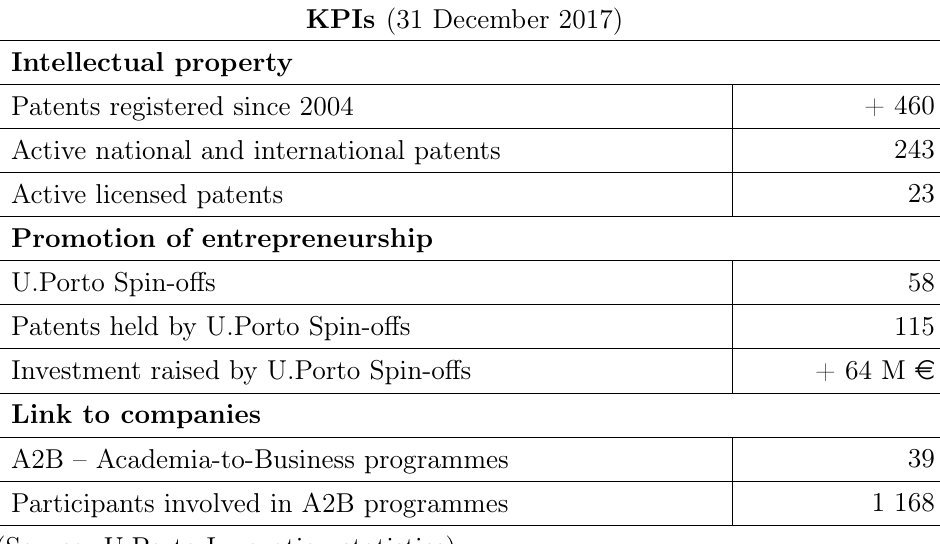
Table 1. U.Porto Innovation: Key Performance